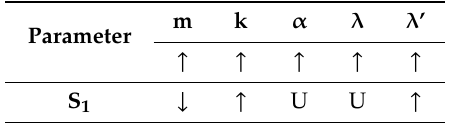
Table 9. Correlation analysis of the parameters in the system.